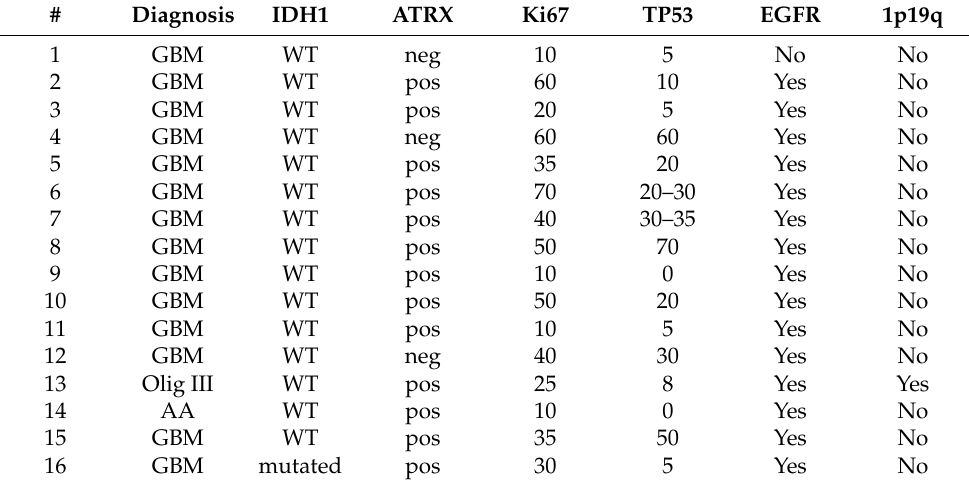
Table 3. Pathology . GBM: glioblastoma multiforme; Olig III: anaplastic oligodendroglioma; AA: anaplastic astrocytoma; WT: wild type; TP53: percentuage of p53-mutated cells; EGFR: amplification of EGFR gene; ATRX: maintenance or deletion of ATRX